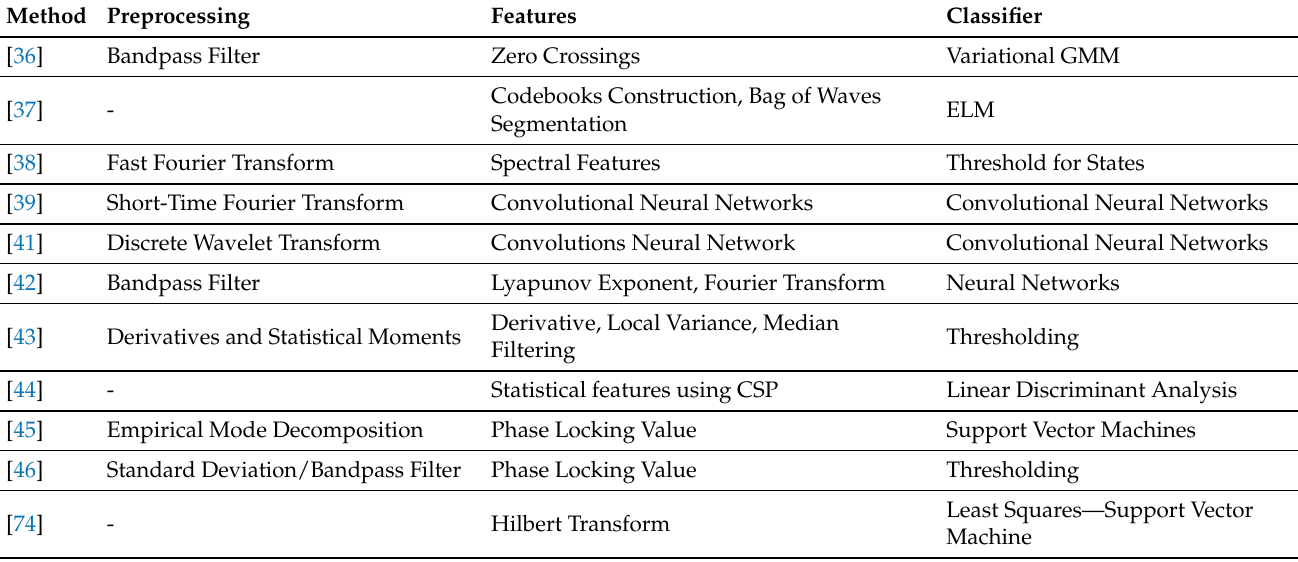
Table 1. Preprocessing, feature extraction, and classifiers in existing